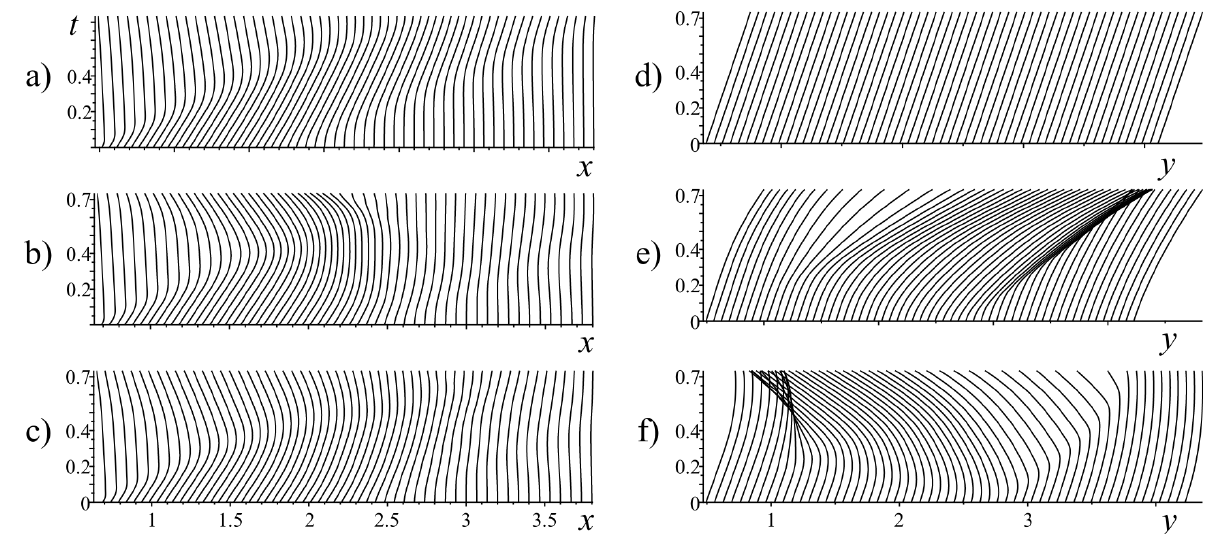
Figure 9. The trajectories of particles under the action of magnetic fields: ( a – c ) show x -trajectories for cases 1, 2, and 3; ( d ) y -trajectories for H 0 = 0; ( e ) y -trajectories for H 0 > 0; ( f ) y -trajectories for H 0 < 0.